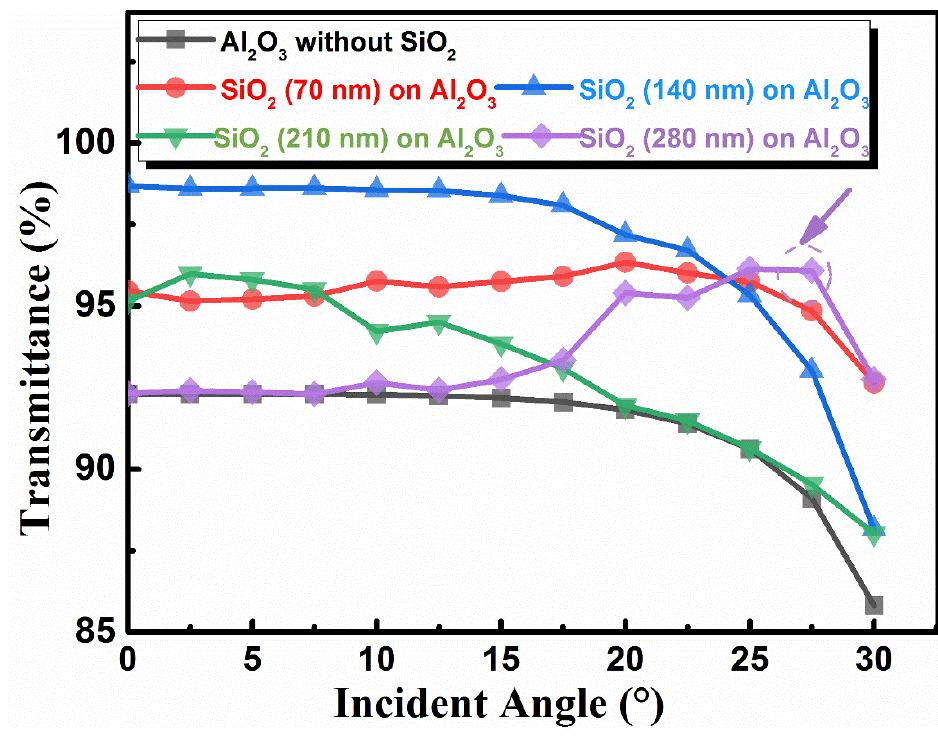
Figure 5. Simulation results of transmittance in 275 nm at different angles.